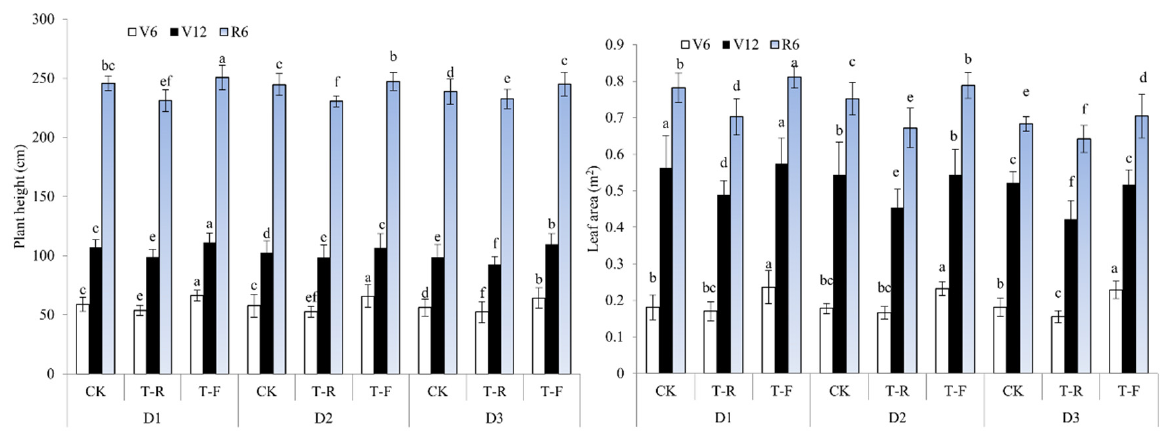
Figure 5. Plant height and leaf area of summer maize under different growing stages (2018). At the same testing time, different letters above the bars indicate that there is a significant difference between treatments at p < 0.05. D1, D2 and D3 represent maize were planted at 60,000, 75,000 and 90,000 plants ha − 1 , respectively. CK and T represent maize planted in the conventional flat planting pattern and in the stereo-planting pattern, respectively. T-R and T-F represent maize were planted on the ridge and in the furrow, respectively. V6, V12, and R6 represent the 6-leaf stage, 12-leaf stage and physiological maturity, respectively. The vertical bar indicates the standard errors ( n = 3).